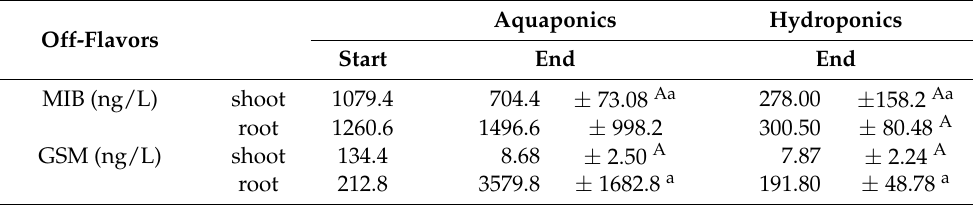
Table 7. Concentrations (ng/L) of off-flavors geosmin (GSM) and 2-methylisoborneol (MIB) in spinach grown in aquaponics and hydroponics in the beginning (5 May) and after six weeks (14 June) of the experiment.